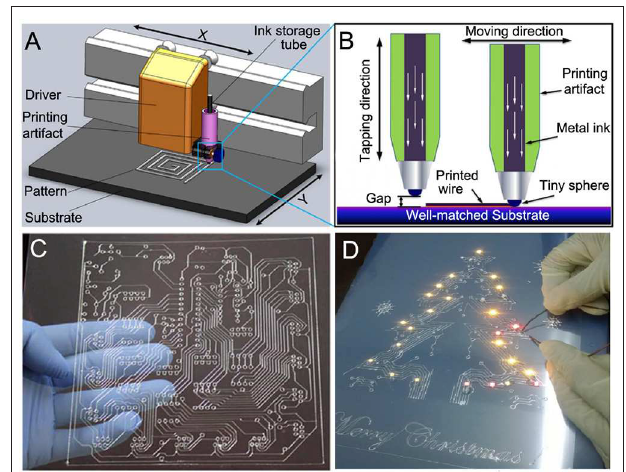
FIGURE 6 | The structure diagram of the tapping mode electronic printing (A) , and the working principle of the printer head (B) , and a flexible printed PCB circuit on PVC substrate (C) , and a printed copy of a Christmas greeting card (D) . Reproduced with permissions from Zheng et al. (2014). Copyright